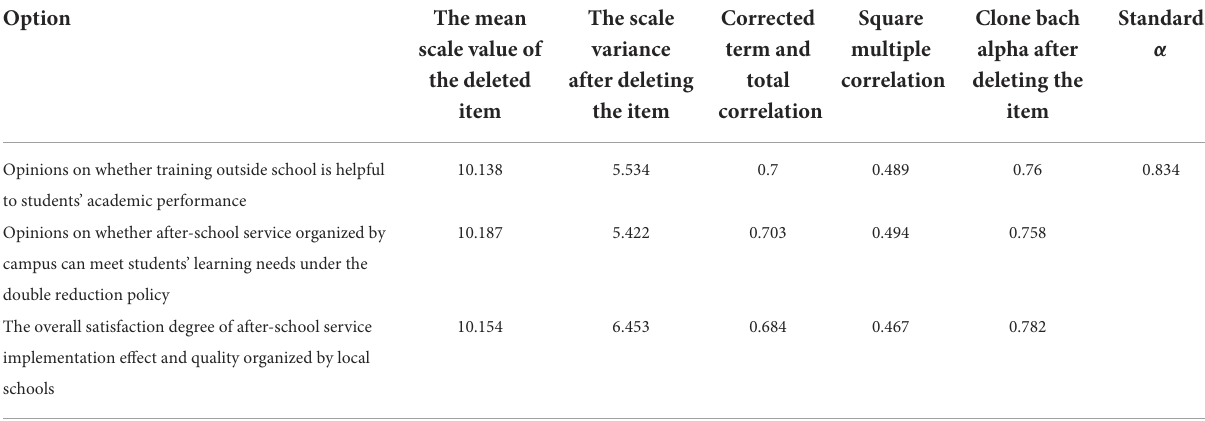
TABLE 5 Views on whether the governance of off-campus training under the double reduction policy is beneficial to students’ learning. Option The mean scale value